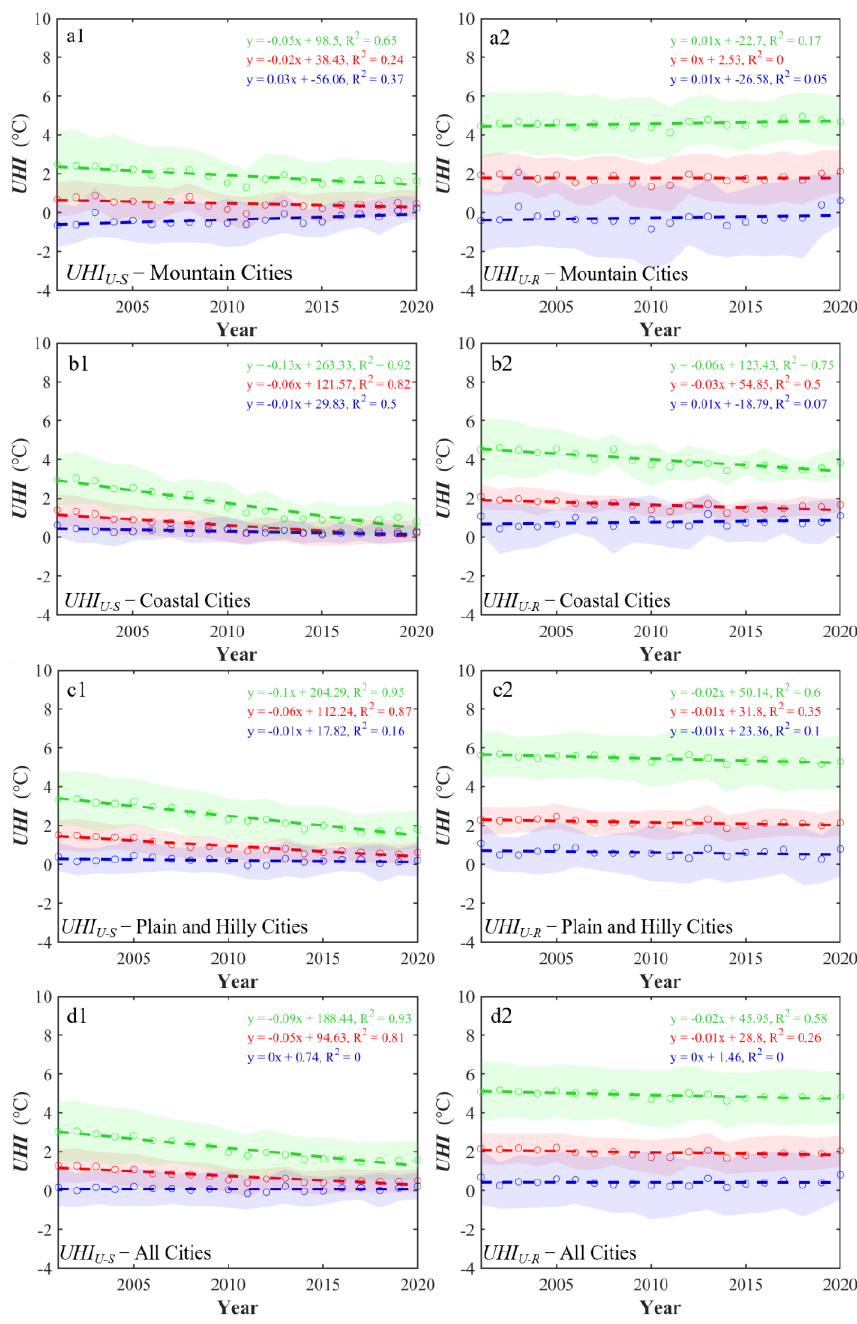
Figure 8. 𝑈𝐻𝐼 𝑈−𝑆 and 𝑈𝐻𝐼 𝑈−𝑅 variations from 2001 to 2020 in mountain cities ( a1 , a2 ), coastal cities ( b1 , b2 ), plain and hilly cities ( c1 , c2 ), and all cities ( d1 , d2 ). Panel numbers 1 and 2 after the panel letters represent 𝑈𝐻𝐼 𝑈−𝑆 and 𝑈𝐻𝐼 𝑈−𝑅 , respectively. Red, green, and blue colors represent annual, summertime, and wintertime results, respectively.